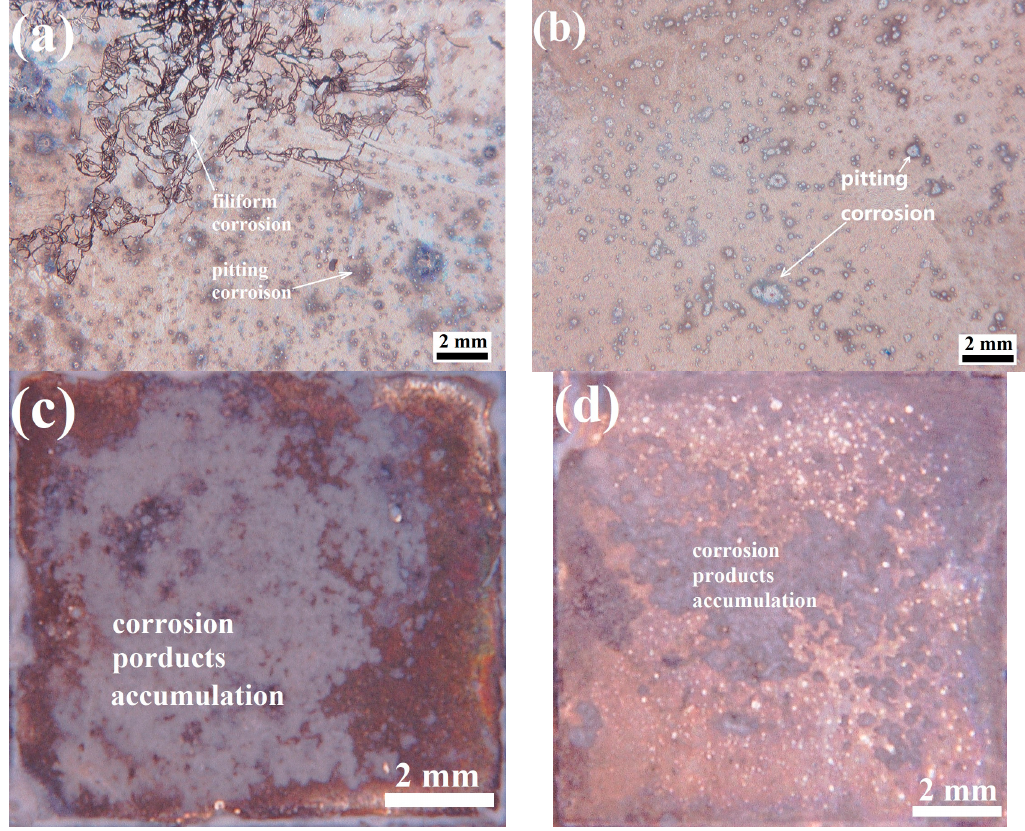
Figure 9. Optical surface corrosion morphologies of the Mg-9Li alloys after hydrogen evolution corrosion for different times. ( a ) Cast alloy after 4h corrosion; ( b ) SS alloy after 4 h corrosion; ( c ) cast alloy after 10-day corrosion; and ( d ) SS alloy after 10-day corrosion.